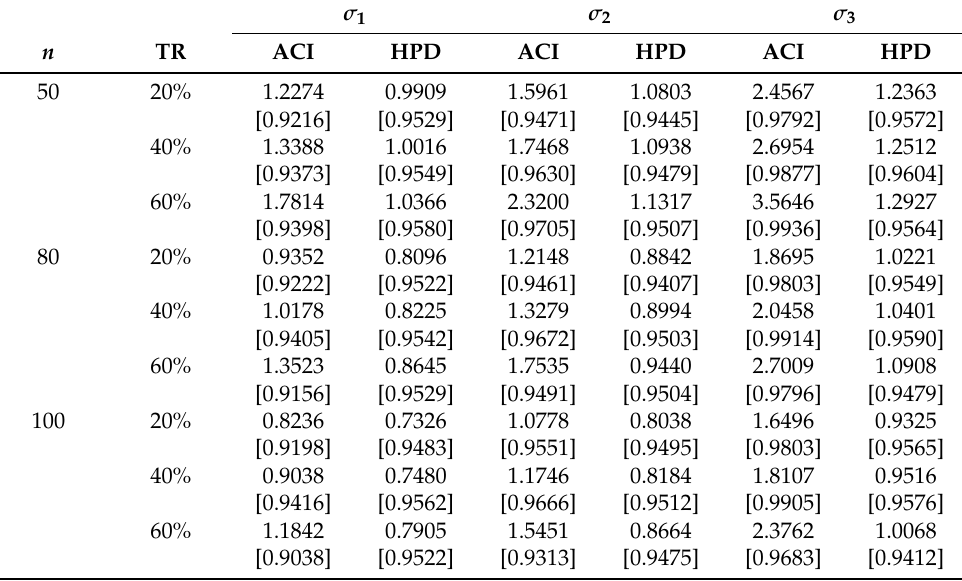
Table 6. ALs and CPs (within bracket) for parameters without order restriction when ( σ 1 , σ 2 , σ 3 ) = ( 1,1.3,2 )